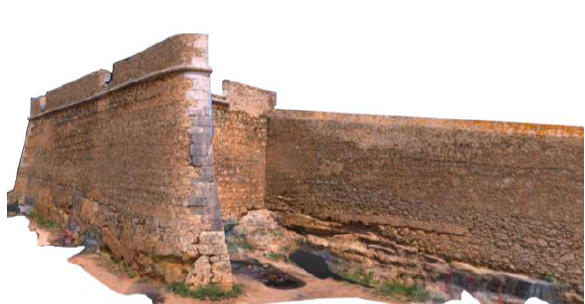
Figure 4. Partial view of the low-resolution photogrammetric model